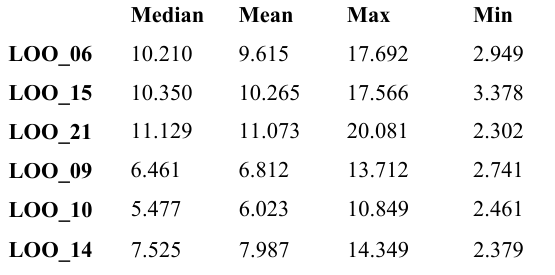
Table 2. Statistical analysis of the distance matrix for the maximum and minimum group